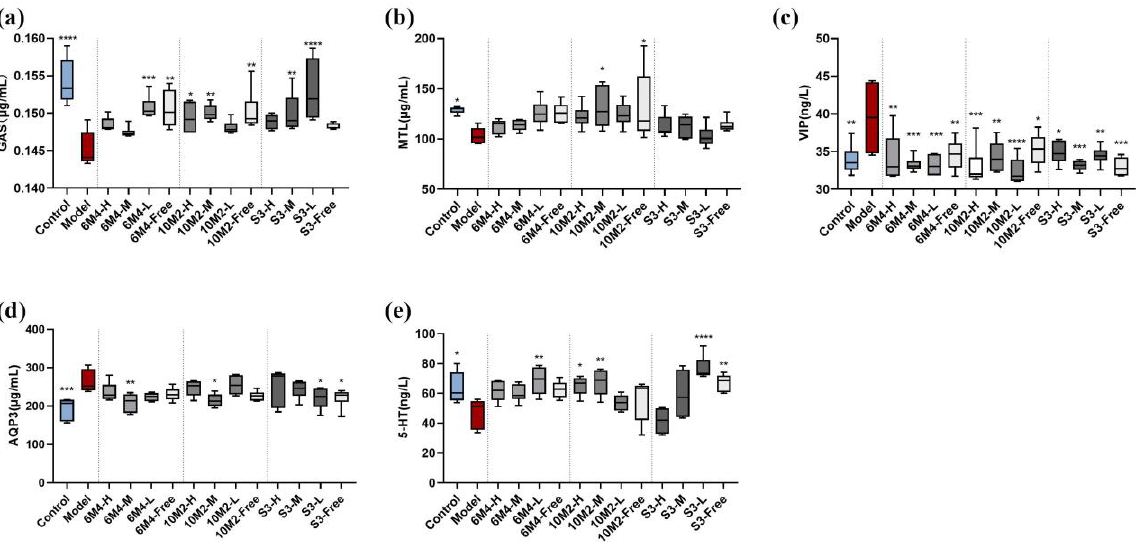
Figure 3. Serum gastrointestinal active peptide levels ( a – c ), colonic aquaporin-3, and serotonin levels. ( a ) Serum gastrin (GAS); ( b ) serum motilin (MTL); ( c ) serum vasoactive intestinal peptide (VIP); ( d ) colonic aquaporin-3 (AQP3); ( e ) colonic serotonin (5-HT). Data are shown as mean ± SD ( n = 6). * p < 0.05, ** p < 0.01, *** p < 0.001, **** p < 0.0001, compared with the model group.